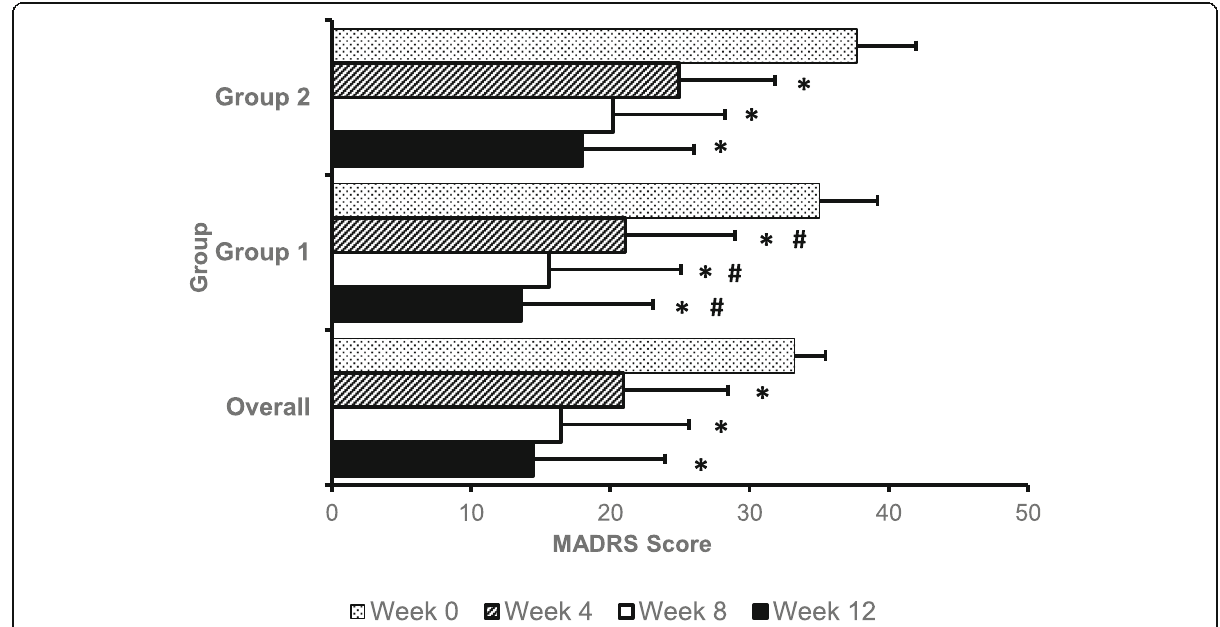
Fig. 3 Mean change in MADRS scores with escitalopram therapy. Group 1: baseline HDRS-17 score between 18 and 23 ( n = 91). Group 2 — HDRS-